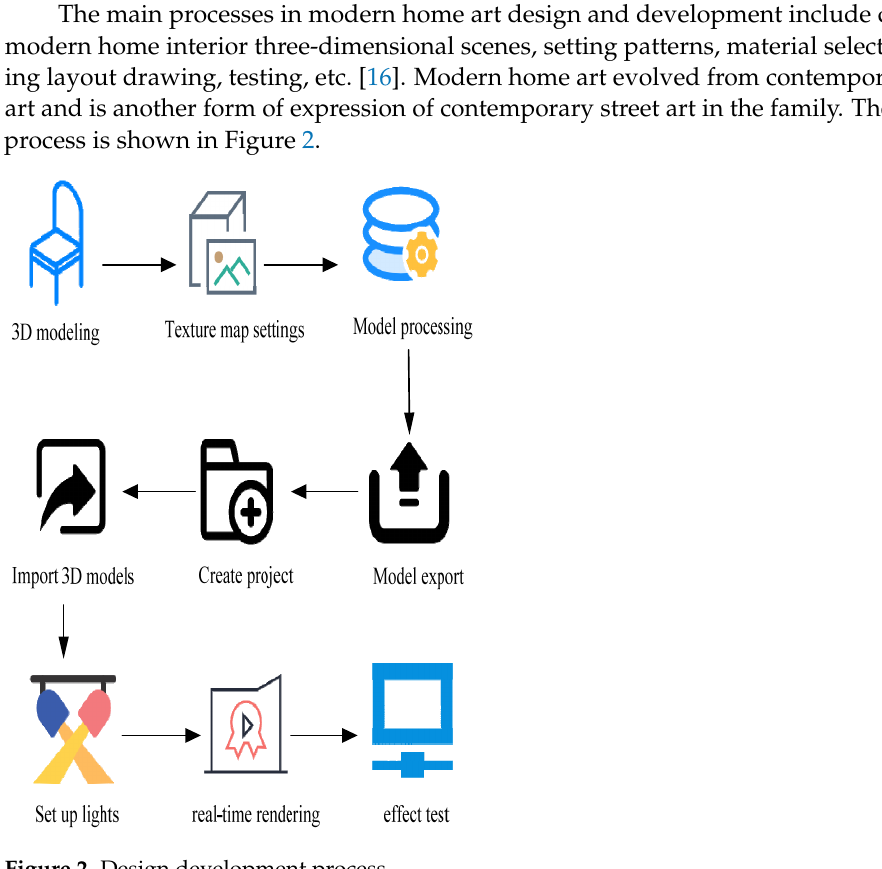
Figure 1. Shader processing flow.